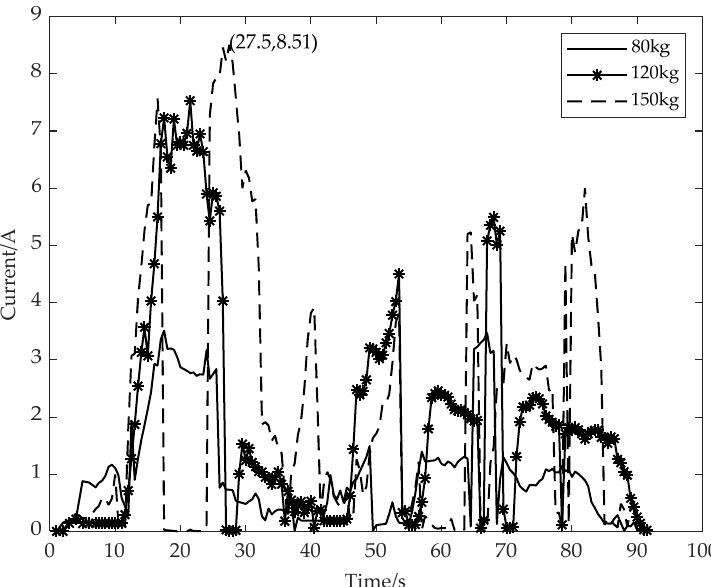
Figure 20. Motor current change curve under different load